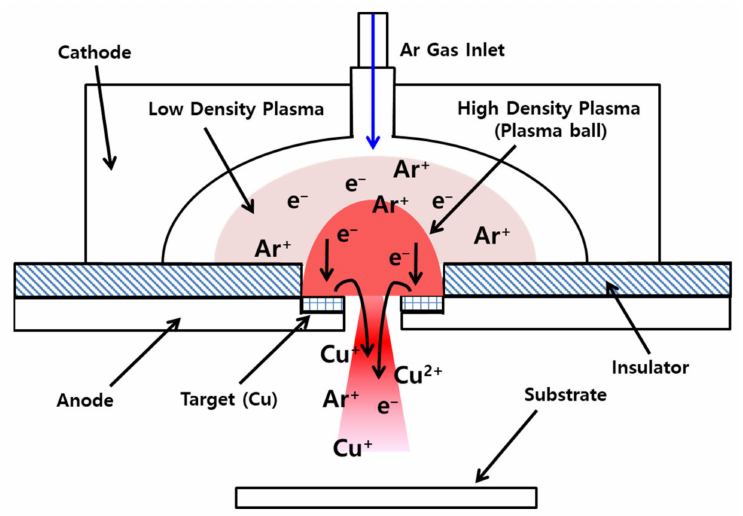
Figure 2. Principle of hollow-anode plasma source for sputtering processes. It uses a high-density plasma (plasma ball) formed near a hollow and after an applied voltage